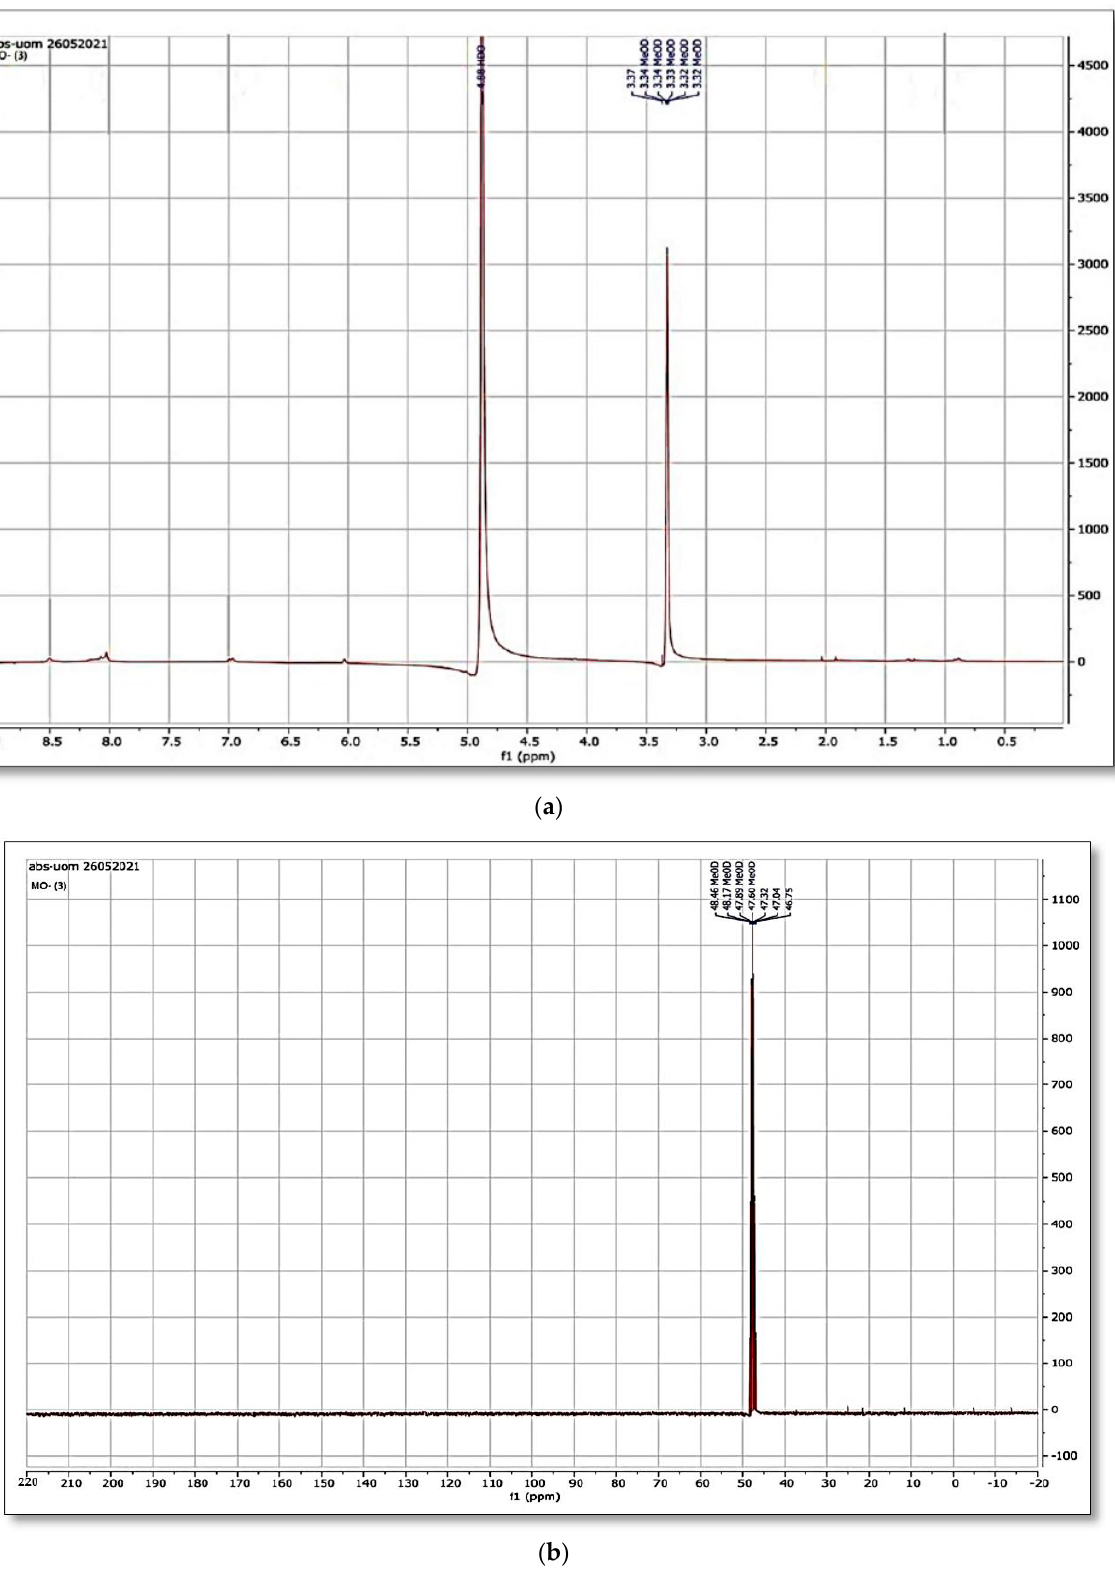
Figure 13. ( a ) 1H NMR degradation by Pseudomonas aeruginosa. ( b ) 13 C NMR after Pseudomonas aeruginosa methyl orange degradation.